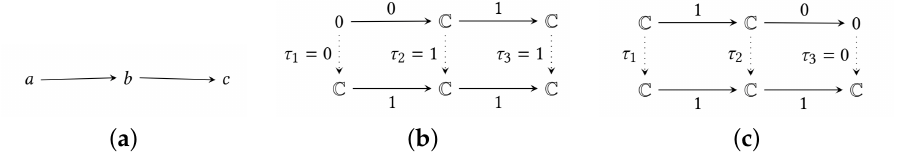
Figure 11. ( a ) A quiver Q . ( b ) A diagram showing a quiver representation of Q at the bottom and a sub-representation at the top together with the morphism of representations τ from Definition 29 given by dotted oriented edges. ( c ) A diagram showing a quiver representation of Q at the bottom and another one at the top. The representation at the top is not a sub-representation of the bottom representation because there is no possible choice of morphism of representations τ that is injective in every